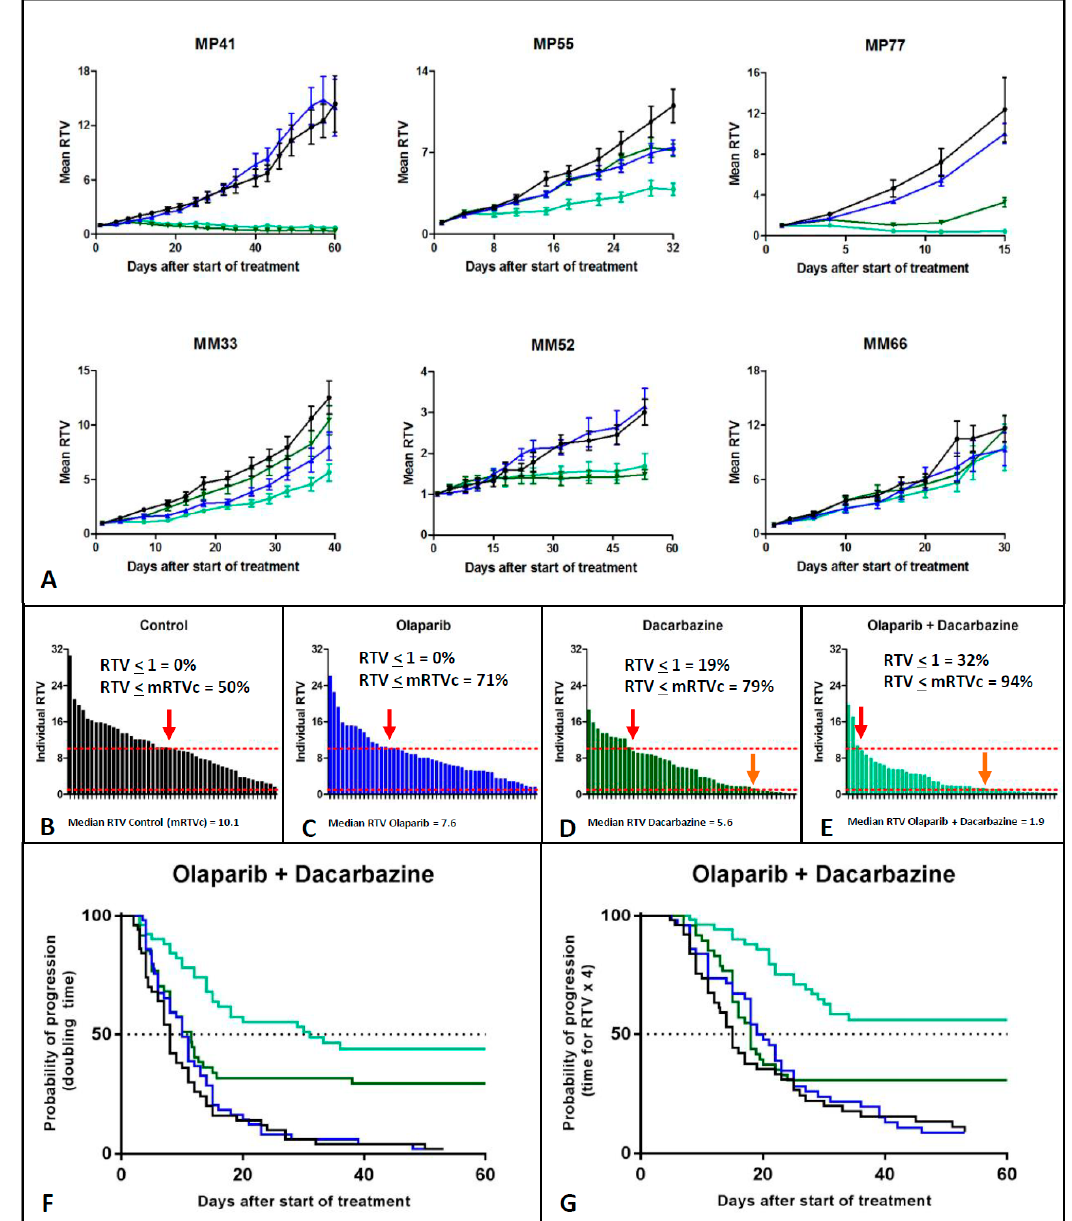
Figure 3. Combination of olaparib and dacarbazine. ( A ) Growth curves of all treated models. ( B–E ) ORR of the four experimental groups, i.e., control (black), olaparib (blue), dacarbazine (dark green), and olaparib + dacarbazine (light green), respectively. RTV: Relative tumor variation. mRTVc: median relative tumor volume of the corresponding control group ( F – G ). Probability of progression of the four experimental groups: doubling time ( F ) and quadrupling time ( G ).